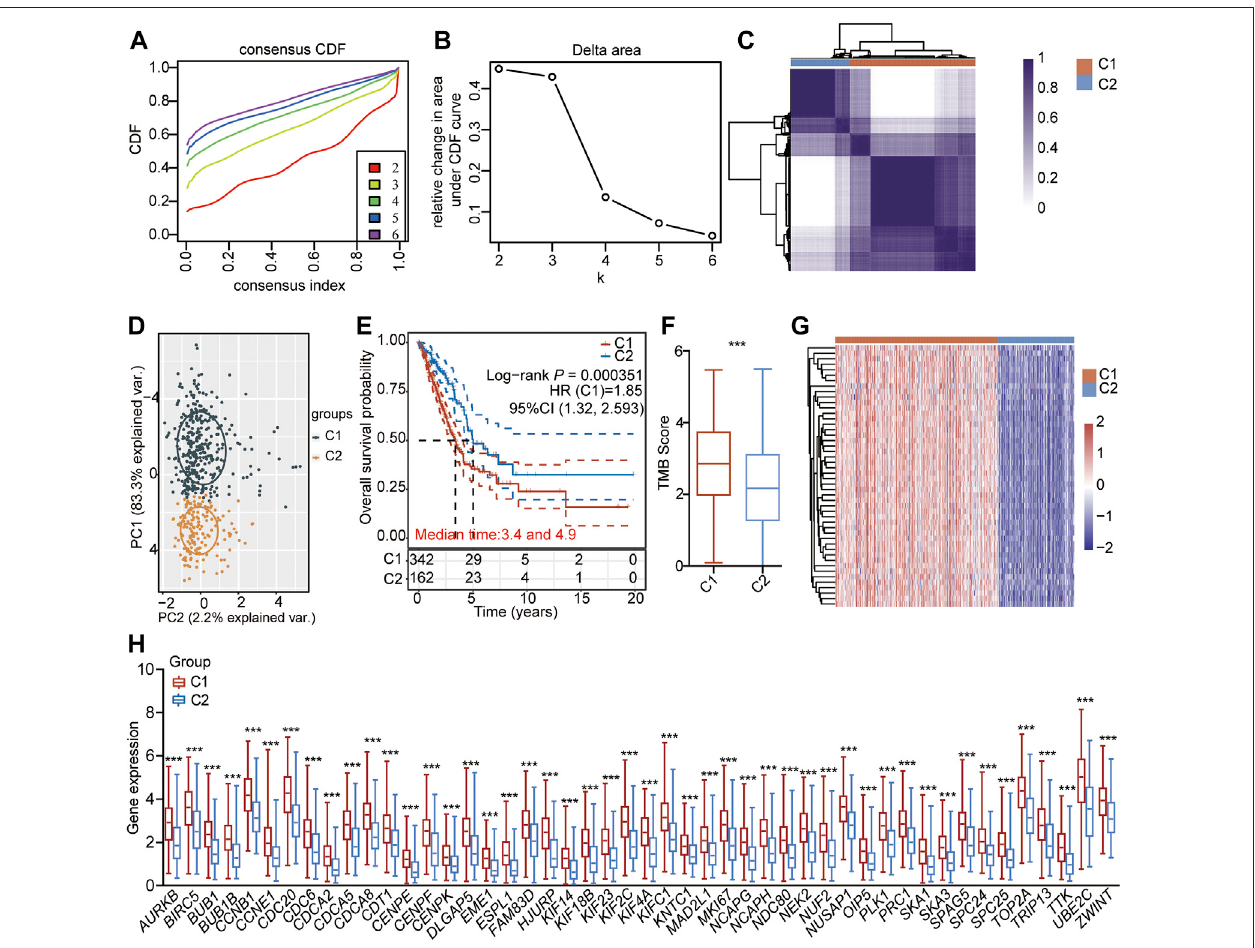
FIGURE5| UnsupervisedconsensusclusteringofLUAD-samplesbasedonthe48CSRs. (A) Consistentcumulativedistributionshowsthecumulativedistribution functionwithdifferentvaluesofk,whichisusedtojudgetheoptimalvalueofk. (B) Deltaareamap. (C) Theconsistencymatrixofalldatasetswithk=2. (D) PCAshowing the LUAD-samples were divided into two distinct clusters. (E) The OS of LUAD-patients in the cluster 1 and 2. (F) The difference in TMB between the two clusters. The signi fi cance was calculated by Wilcoxon rank-sum test. *** p < 0.001. (G) Heatmap showing the expression pattern of the 48 CSRs in the two clusters. (H) The 48 CSRs were all highly expressed in cluster 1. The signi fi cance was calculated by Wilcoxon rank-sum test. *** p < 0.001.